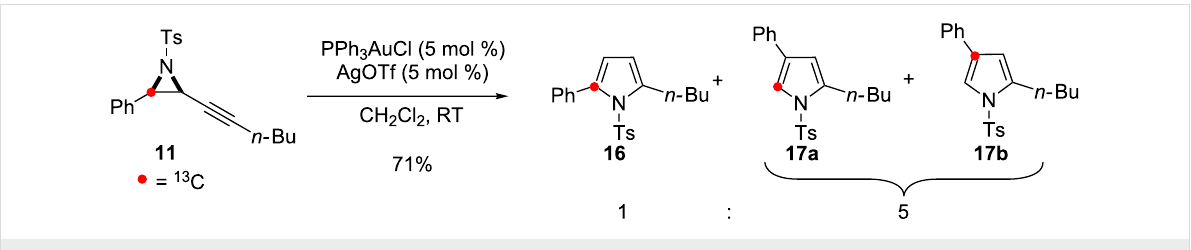
Scheme 7: Cycloisomerisation of 11 in the skeletal rearrangement reaction.